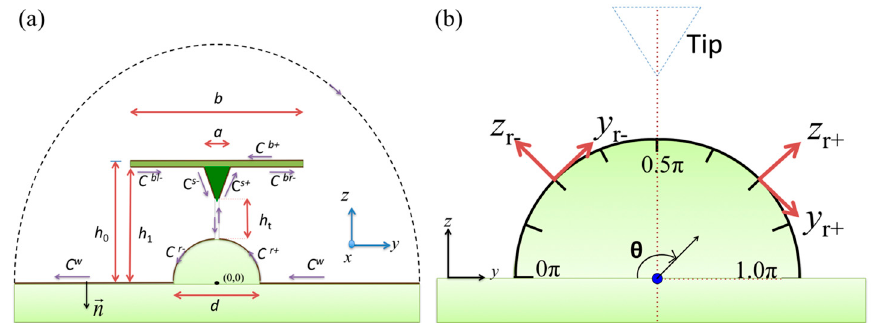
Figure 1. Two-dimensional cross-section of the probe, tip, and specimen: ( a ) integral path of the semi-analytical method in the global coordinate system and ( b ) local coordinate system relative to the semicircular specimen.